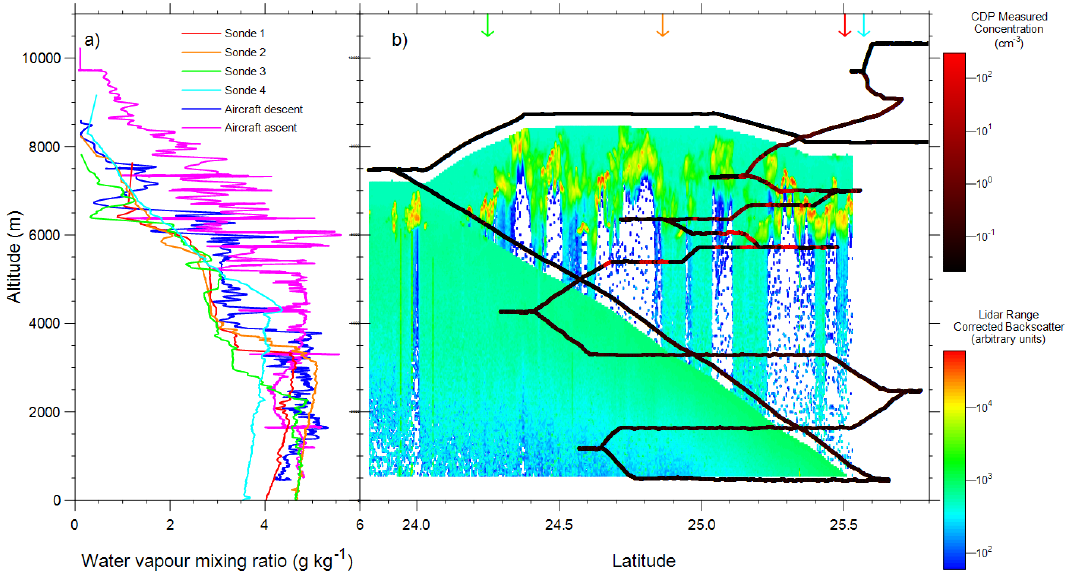
Figure 7. b609 dropsonde/aircraft moisture profiles and range-corrected lidar cross section of 1934 the scientific area of interest (red–blue colour scale, arbitrary logarithmic units) including an aircraft track coloured by the droplet concentration as measured by the CDP plus PCASP (black to red colour scale). The lidar data collected during descent (thick sloping black line) are plotted instead of the high-level data when available. Above this, lidar data from the high-level flight leg are shown. Arrows indicate locations of dropsondes. Sondes 1–3 were dropped on entry to the area and sonde 4 on